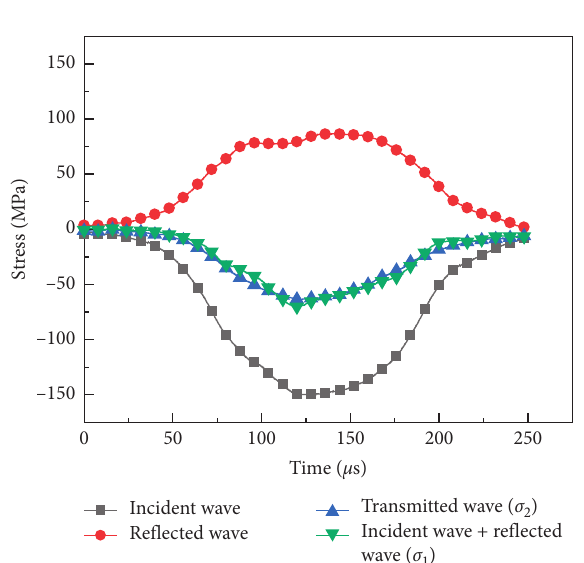
Figure 3: SHPB test system.